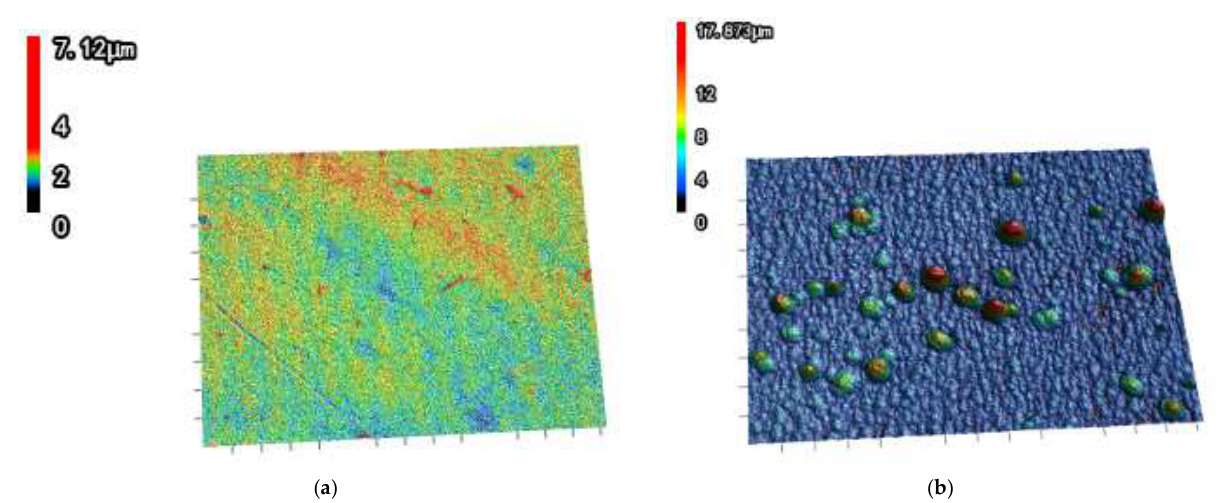
Figure 3. Bottom morphology of microgroove under ( a ) 60% overlapping rates and ( b ) 90% over- lapping rates.